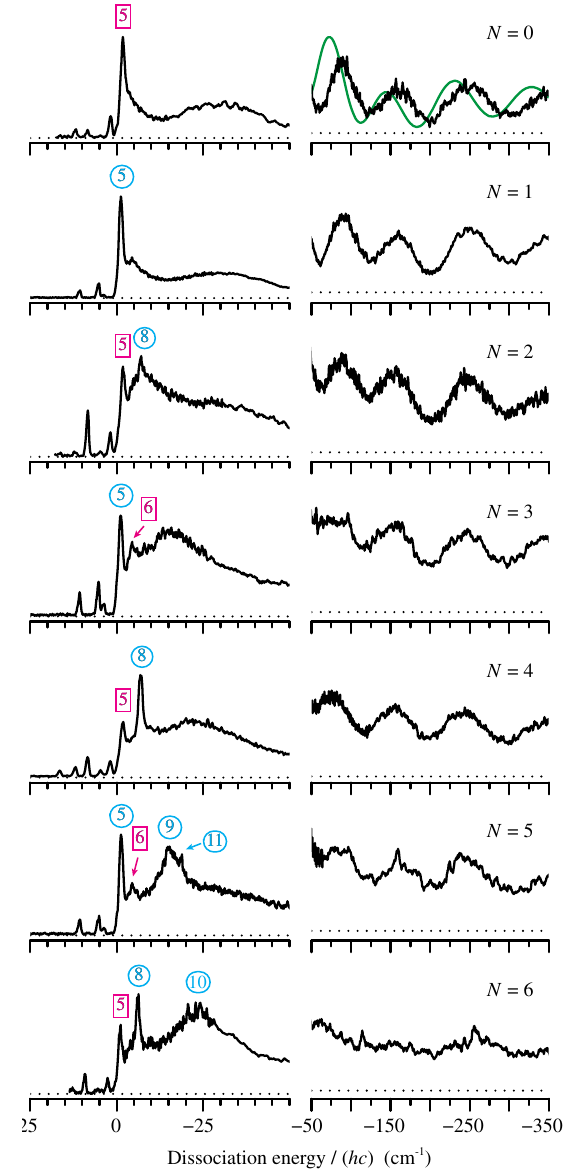
FIG. 4. PFI-ZEKE photoelectron spectra of D 2 recorded with pulse 9 ( − 670 mV = cm) of the field-ionization sequence from the N ¼ 0 – 6 rotational levels of the ¯ H ð v ¼ 12 Þ state. The resonances associated with the X þ and A þ states are labeled with the value of N þ surrounded by circles and squares, respectively. The left panels show the region where the shape resonances dominate and the right panels present the region where the spectra are dominated by the slow oscillations of the Franck-Condon factors on an expanded vertical scale (× 2 ) and reduced horizontal scale (× 0 . 25 ). The green trace in the top right panel corresponds to calculated Franck-Condon factors (see text). The dotted lines give the zero-signal